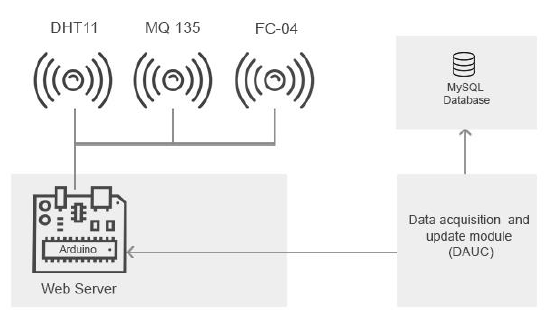
Figure 5 Overview of the